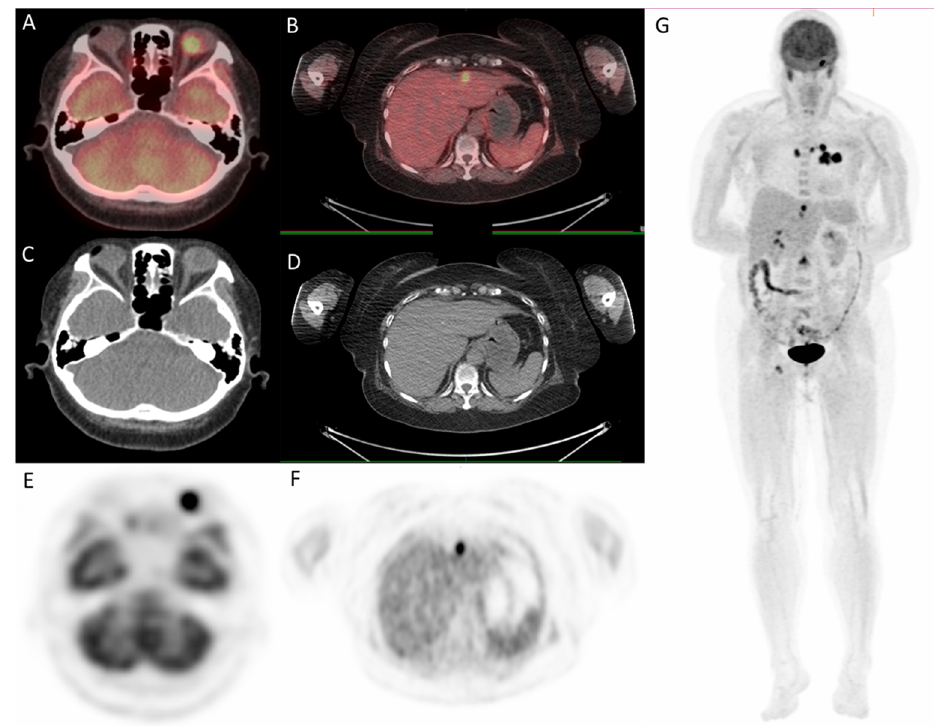
Figure 5. 18 F-fludeoxyglucose positron emission tomography/computed tomography ( 18 F-FDG PET/CT) for whole-body evaluation. ( A , B ) axial fused PET/CT showing focal uptake of the lung and mediastinum, respectively; ( C , D ) axial CT; ( E , F ) PET.